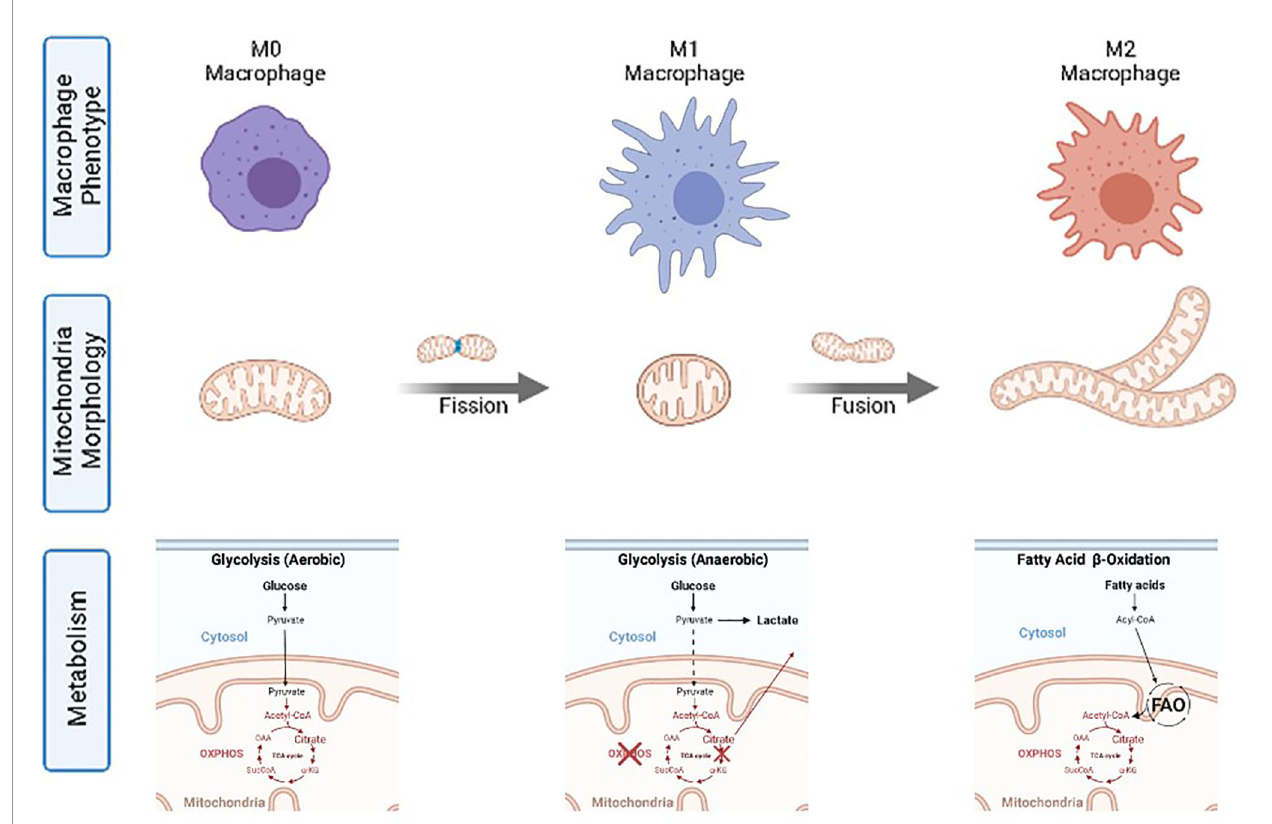
FIGURE 2 | Macrophage phenotypes, mitochondria morphology and corresponding catabolic